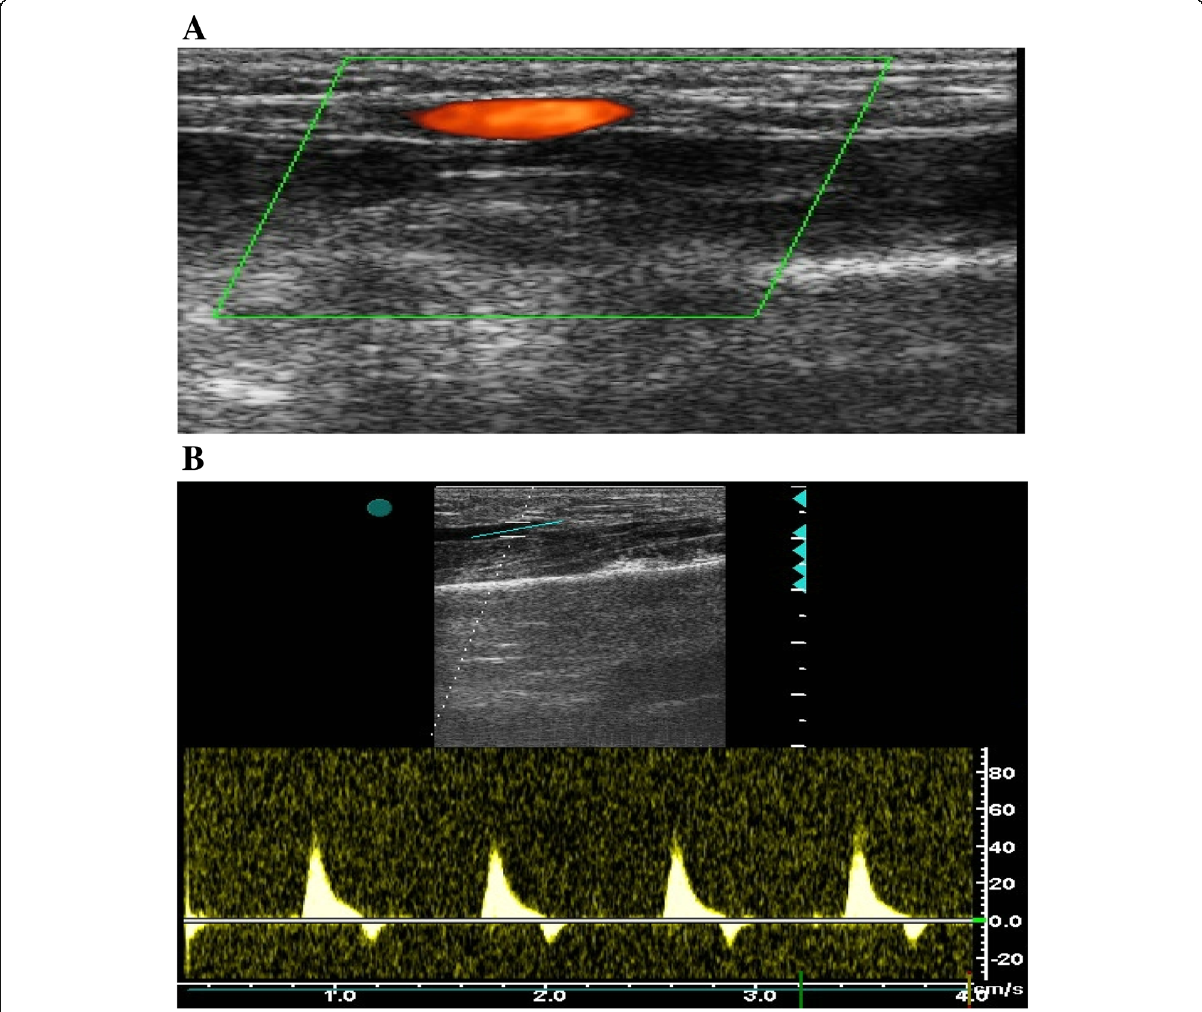
Fig. 2 Duplex ultrasonography of a patent RA after TR coronary catheterization. a Color Doppler showing normal flow within the RA. b Spectral analysis showing tri-phasic flow